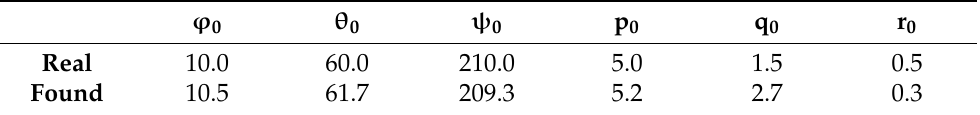
Figure 20. Synthetic test—. In blue, the synthetic light-curve created with VISONE, while in red the light-curve found by the genetic algorithm are shown. Table 2. The initial attitude parameters found by the proposed method on a synthetic dataset in comparison with the real one, where φ 0 , θ 0 , ψ 0 are the Euler angles (in degrees) and p 0 , q 0 , r 0 the angular velocities (in degrees/sec).